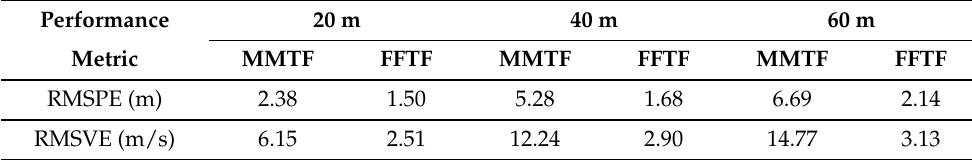
Table 2. Simulation results under various relative distances in the mid-range mode.